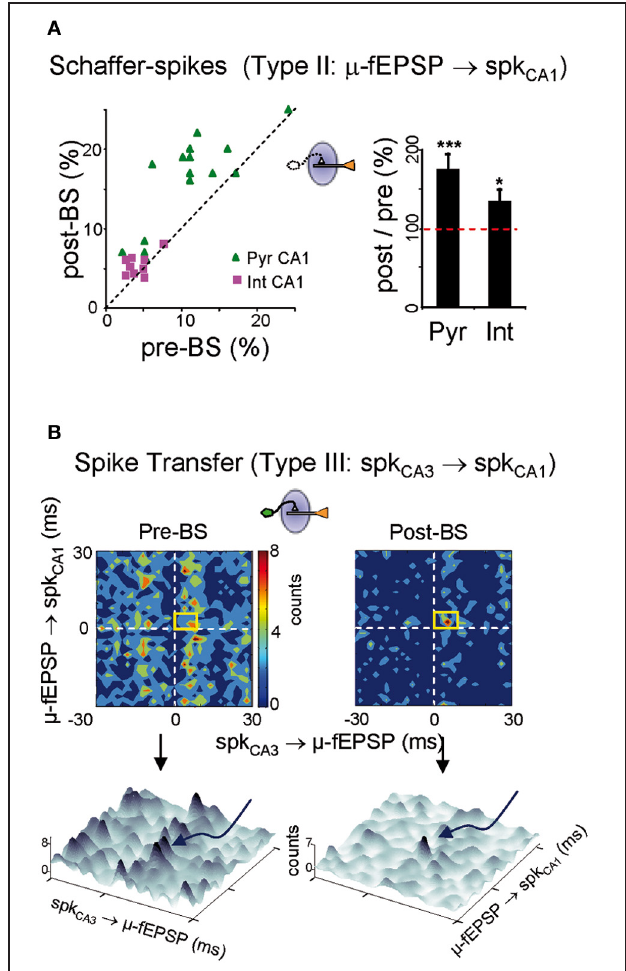
FIGURE 7 | Persistent downstream changes in the CA3-CA1 pathway. (A) Postsynaptic CA1 units increased their share of Schaffer-driven spikes in 25min temporal series 1h after BS. This increment was greater in pyramidal cells (green triangles; Pyr CA1 ) than in interneurons (magenta squares; Int CA1 : ∗∗∗ p < 0 . 001, ∗ p < 0 . 05, Student’s t -test; n = 6 animals). (B) BS increased the spike transfer efficiency and cell-to-population salience of CA3-CA1 pyramidal cells pairs. Color-coded contour densitograms and the corresponding pseudo 3D representations plot the density of the time coincidences of CA3 spikes locked monosynaptically to CA1 μ -fEPSPs against those of CA1 spikes monosynaptically locked to μ -fEPSPs, for one representative experiment (time epochs of 10min before and 1h after BS). The monosynaptic window (6 × 8ms) indicated by the yellow squares captures successful monosynaptic spike transfer between the two cells. In 3D plots these are grouped in the peak marked by curved arrow in pre-BS and the main peak in post-BS. Salience is only increased in pre-post synaptic cell pairs in which the CA3 unit exhibited potentiated STA of the CA1 Schaffer